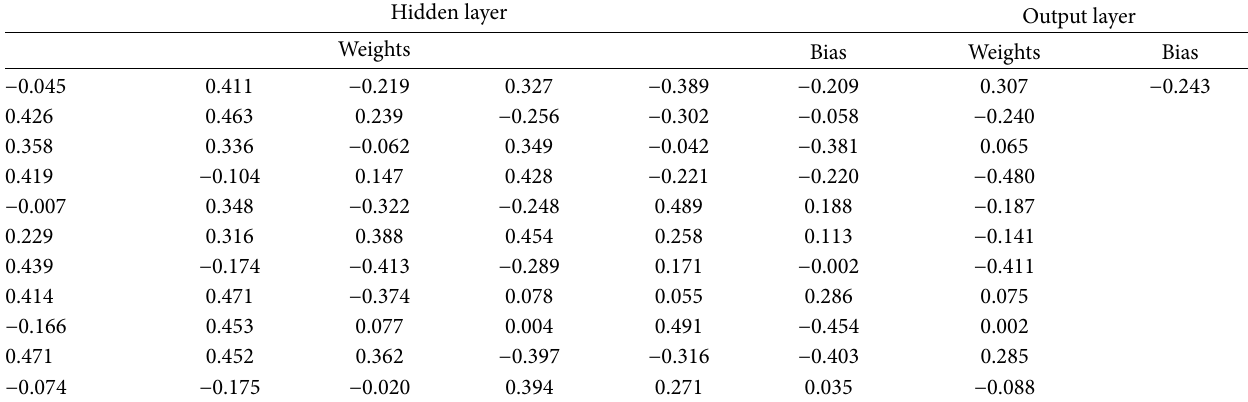
Table 4: Optimal weights and bias for ANN-GA